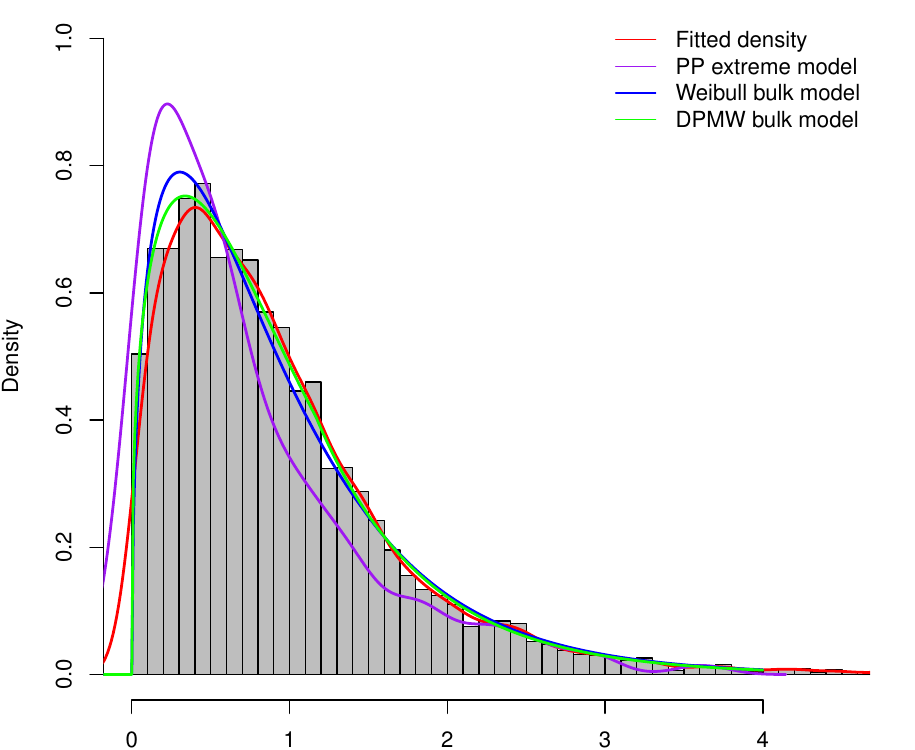
Figure 9. The posterior density plot for three models (the DPMW-PPR model, the PP extreme value model and the WMPP extreme model) with n = 5000. The red line shows the true density function, the green line, the blue line and the purple line are the posterior density function of the DPMW-PPR model, the WMPP extreme model and the PP extreme value model,